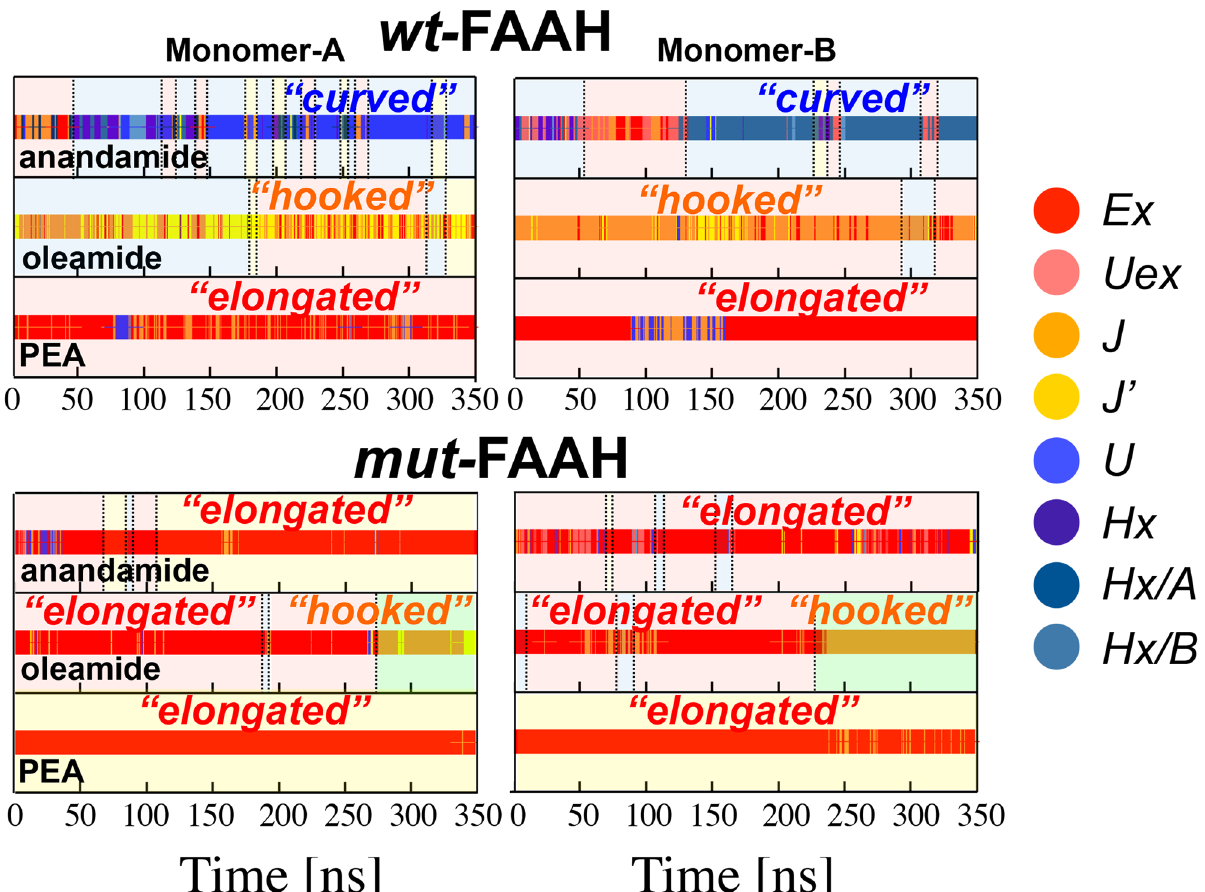
Fig 4. Time evolution of the “ elongated ” (red), “ hooked ” (yellow), and “ curved ” conformations of anandamide (first row), oleamide (second row), and PEA (third row), shown for Monomer-A (first column) and Monomer-B (second column) of the wt -FAAH (upper graphs) and mut -FAAH (lower graphs) systems. Time windows for the substrates location are shown with different background colors: red (MA channel), yellow (AB channel), and cyan (T region). The green background indicates the time windows for the oleamide unbinding in the mut- FAAH. Full details are in the main text, in the S1 Text and in S2